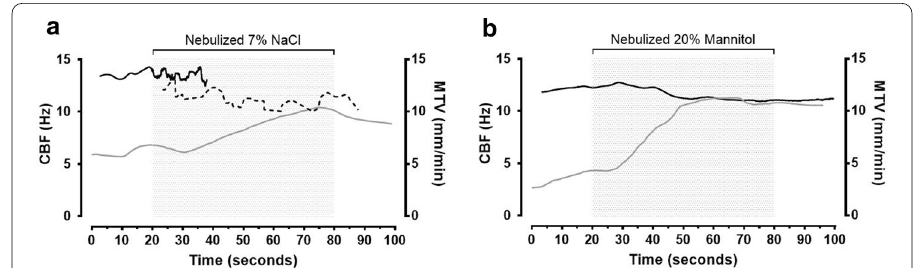
Fig. 8 An example of the effect of nebulized hypertonic saline (7% NaCl) ( a ) and nebulized mannitol (20% Mannitol) ( b ) on the mean cilia beat frequency (CBF) (black) and mucus transport velocity (MTV) (grey) across the field-of-view from a video-microscopy recording shown in Additional file 2: Video S2, Additional file 3: Video S3. The shaded area represents nebulized 7% NaCl in a and nebulized 20% mannitol in b . Different regions were used for CBF analysis in a shown as a solid black line for measurements made over the entire field-of-view and a dashed line showing measurements made in a sub-region in the top left corner or the recording, since an abundance of debris prevented robust measurement in other portions of the frame